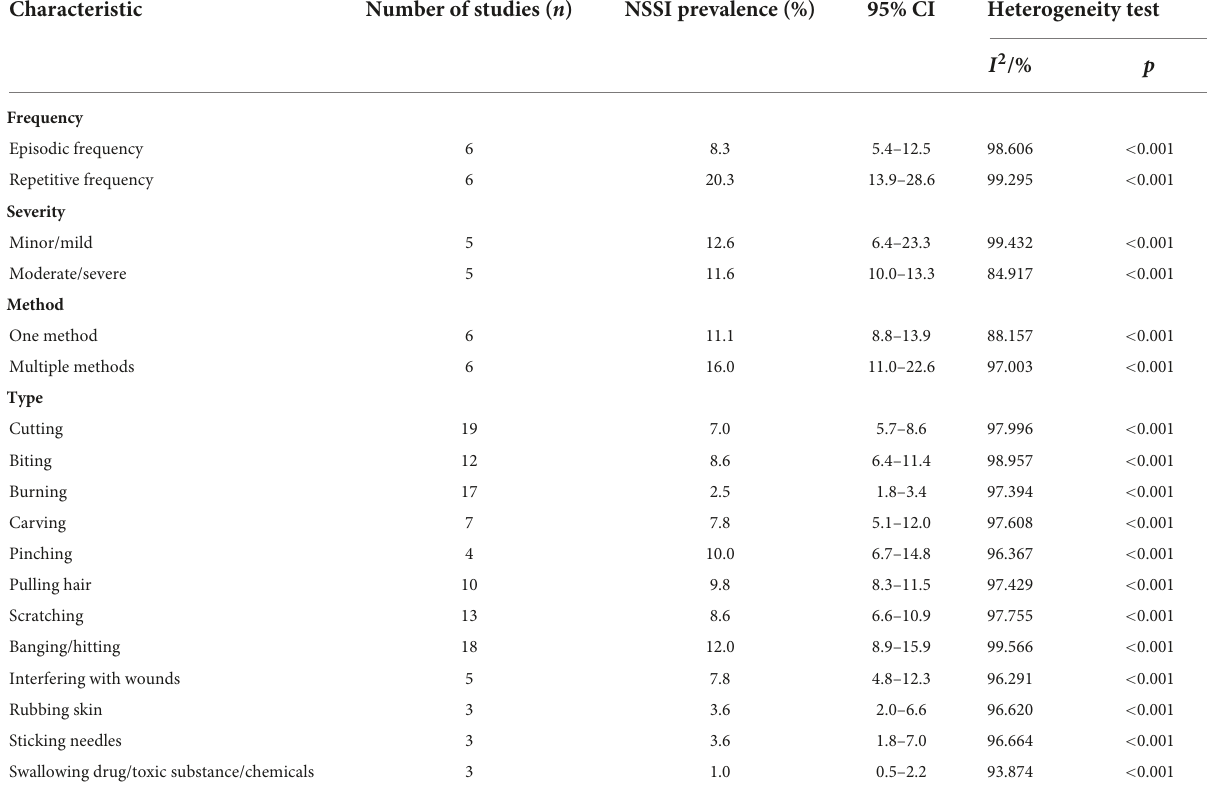
TABLE 3 Prevalence of characteristics of non-suicidal self-injury in adolescents. Characteristic